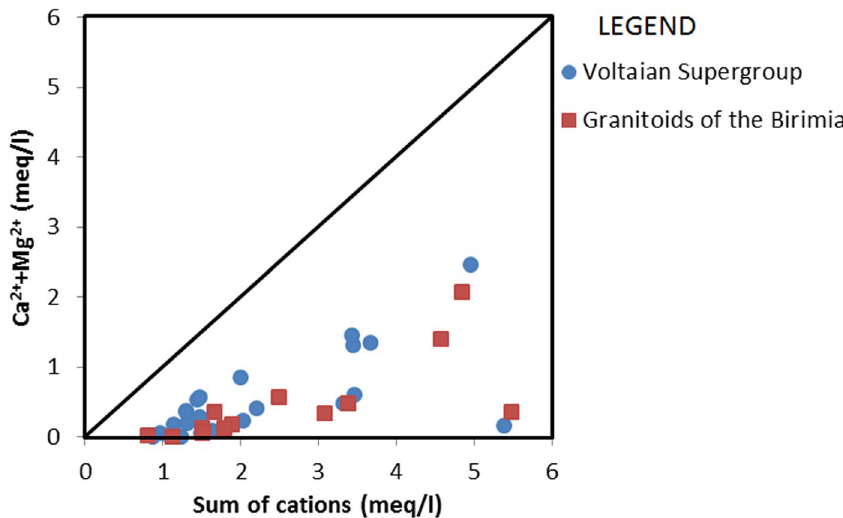
Fig. 7 A plot of (Ca2 + + Mg2 +) vs. TZ + of groundwater of the study